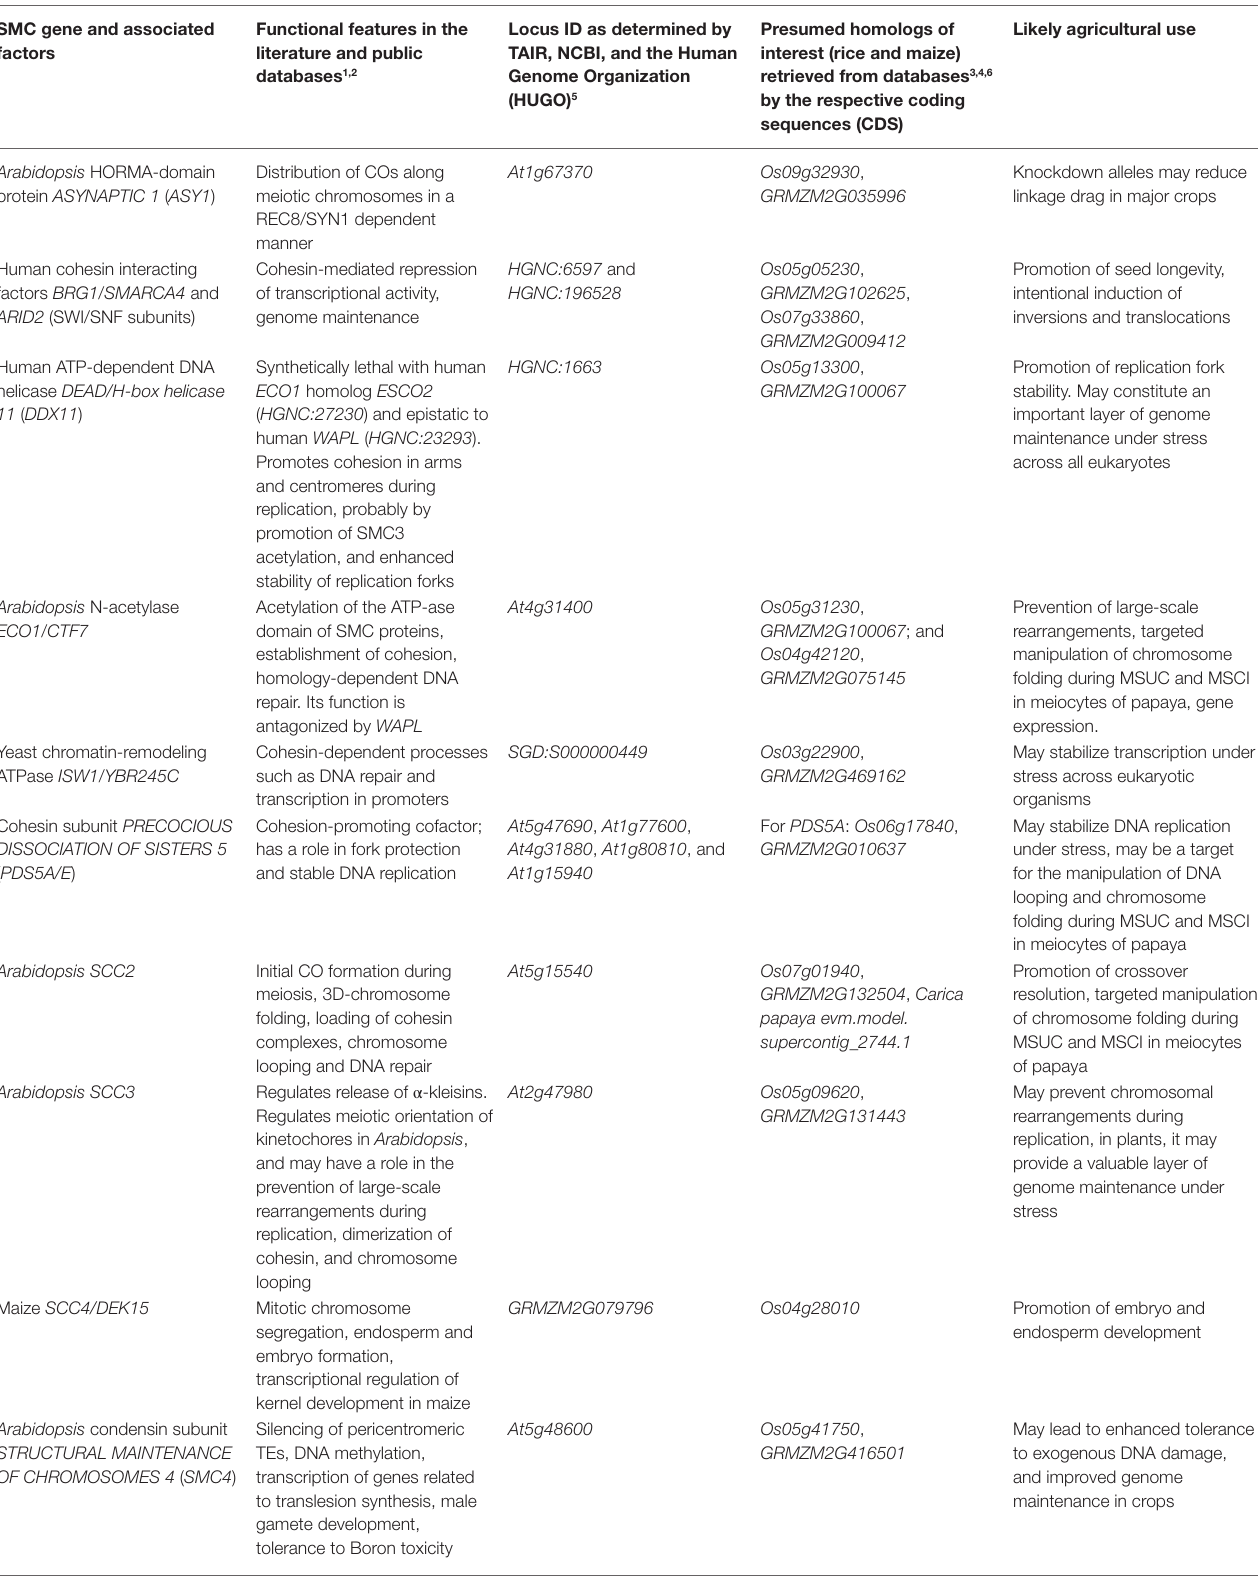
TABLE 1 | Selection of cohesin/SMC genes and cofactors with potential for inclusion in breeding initiatives in major crops. SMC gene and associated